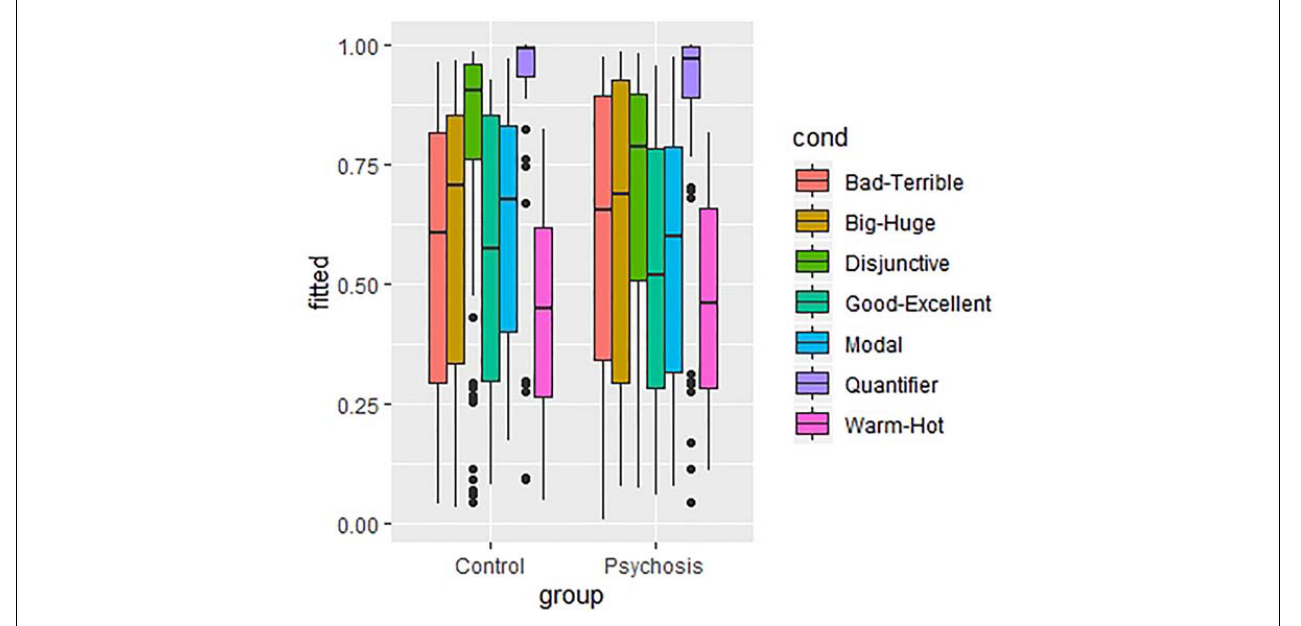
FIGURE 1 | The boxplots of the fitted values of the final model for the different scalar types for control participants and participants diagnosed with Schizophrenia Spectrum and Other Psychotic